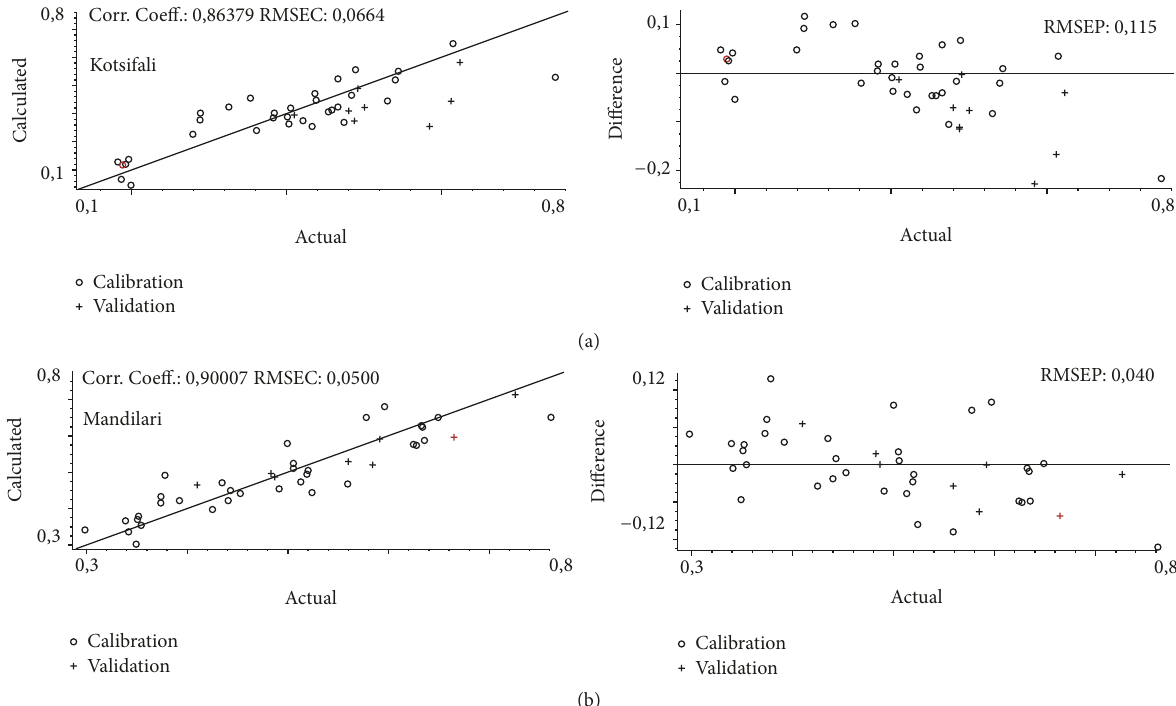
Figure 3: Correlation between the actual chemical age i values and the values predicted by the model for Kotsifali (a) and Mandilari (b) samples.